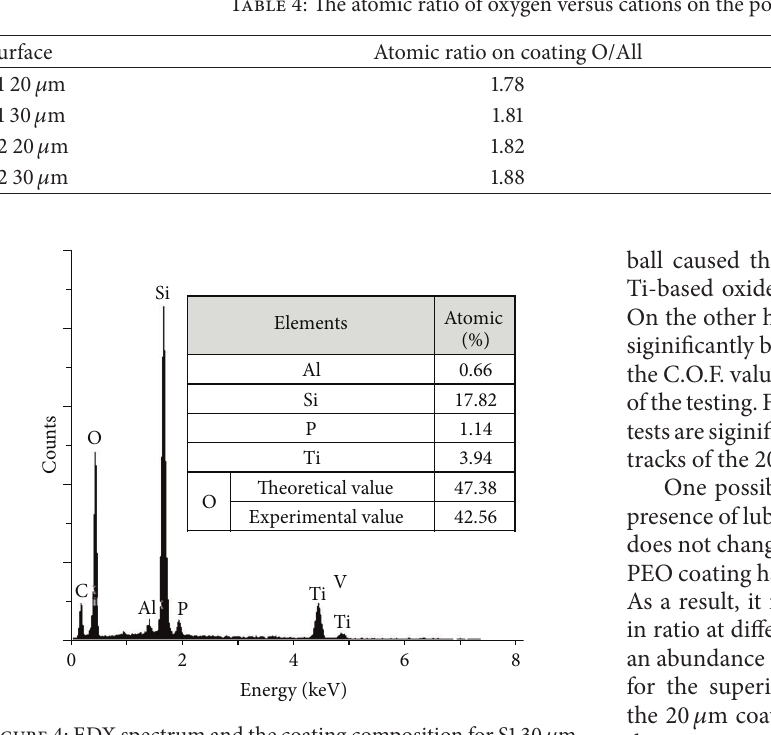
Figure 4: EDX spectrum and the coating composition for S1 30 𝜇